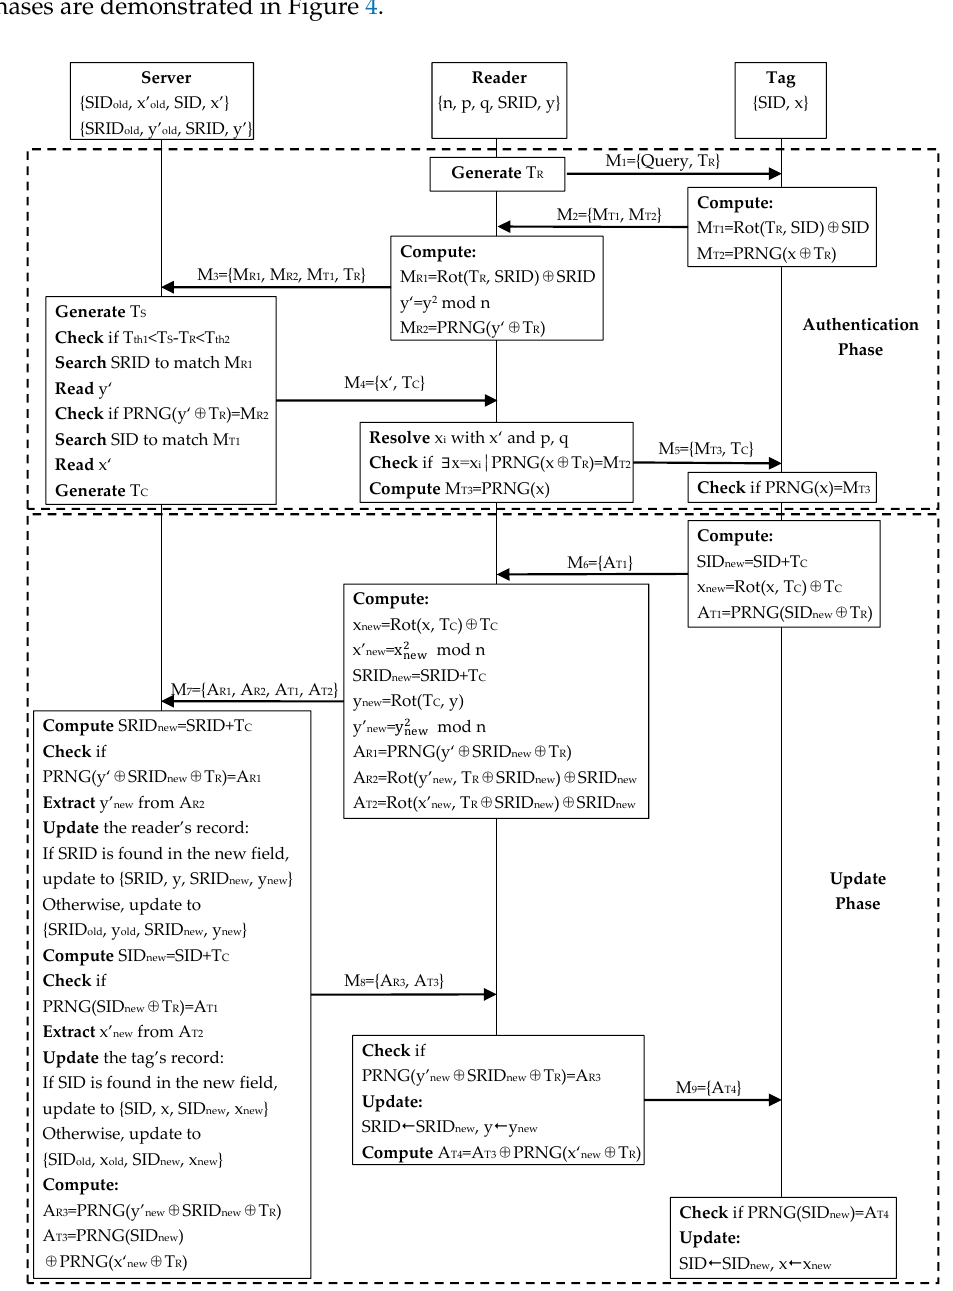
Figure 4. Authentication and update phases of Fan et al.’s scheme.